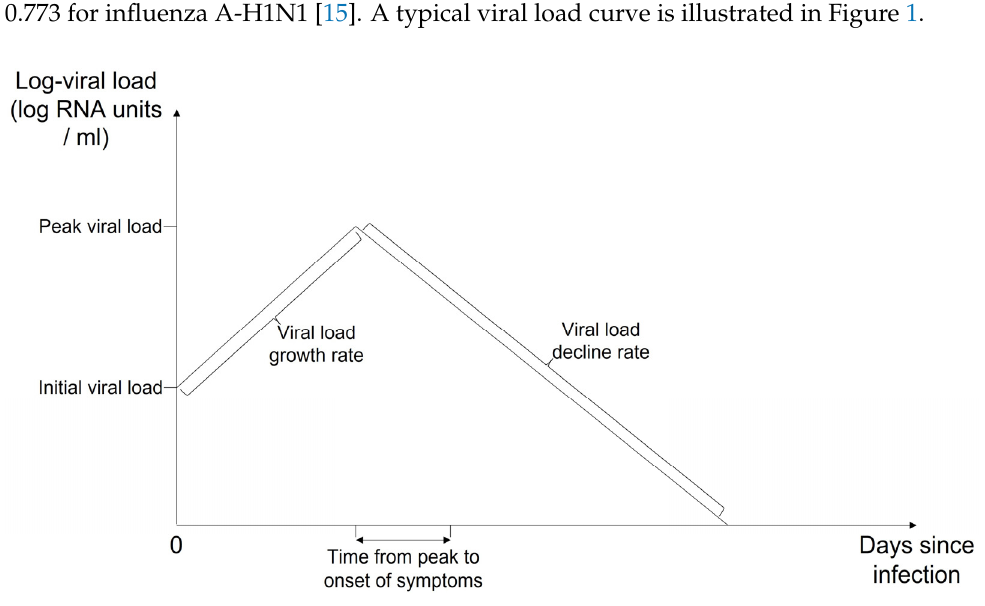
Figure 1. Typical log viral load curve by days since infection, labelled with parameters: peak viral load, initial viral load, viral load growth rate, viral load decline rate, time from peak to onset of symptoms.